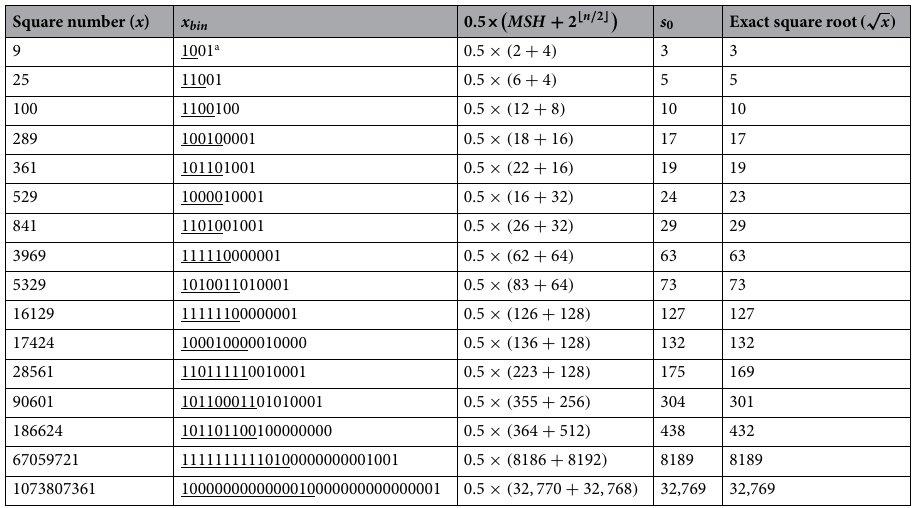
a The underlined half of the binary